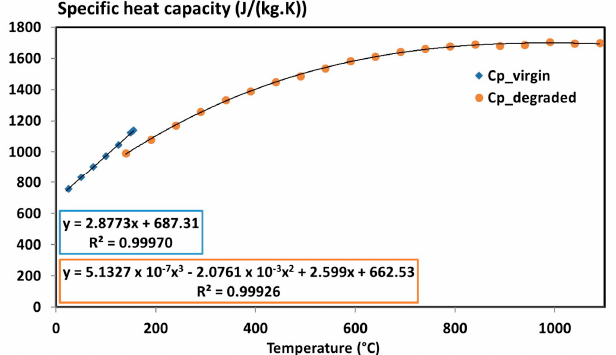
Figure 5. Specific heat capacity of the virgin and degraded materials obtained with DSC Q100 and STA F1 measurements, respectively [6].